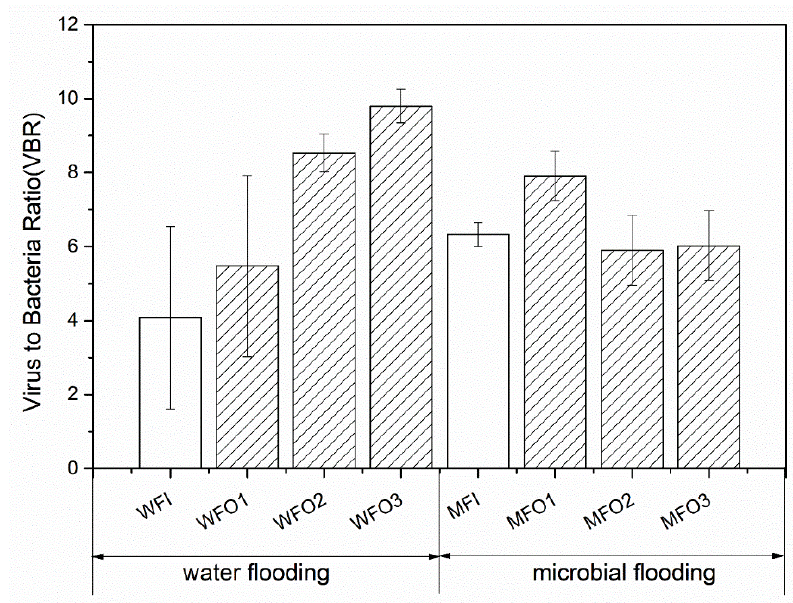
Figure 4. The ratio of viral to bacterial abundance for each sample in the Daqing oilfield. The bars with slash represent production wells, and bars without slash represent the injection well.